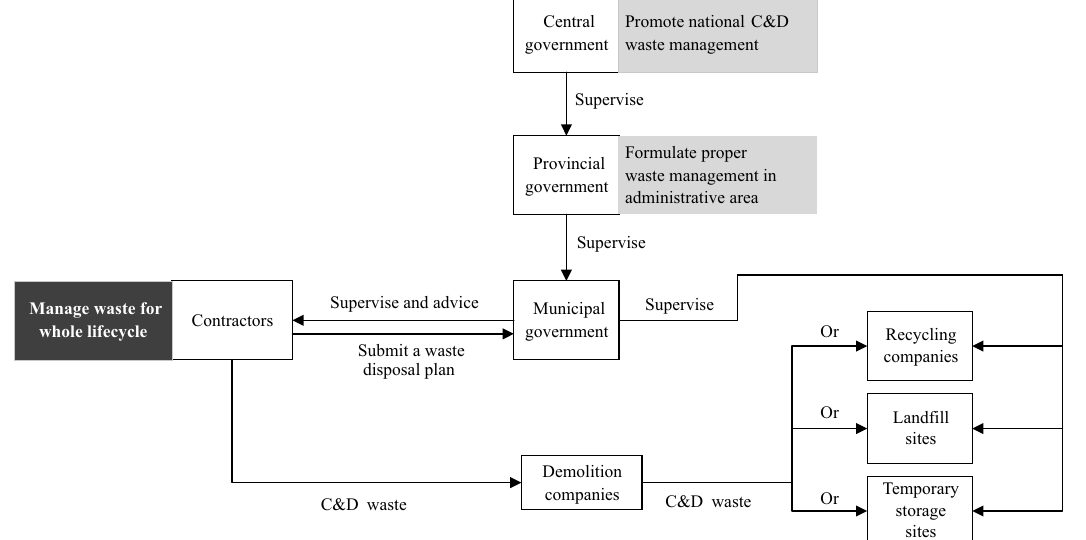
Figure 2. Responsibilities of related stakeholders in China (based on Ministry of Housing and Urban-Rural Development